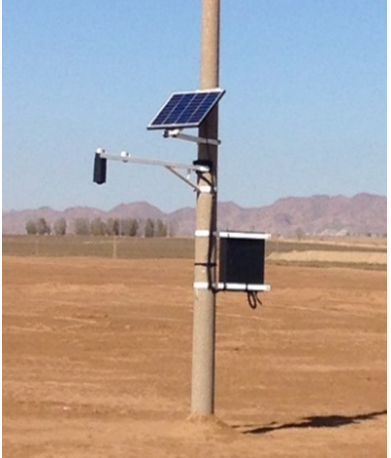
Figure 3. The automatic surface-reflected radiance measurement system over the desert target at the Baotou site.